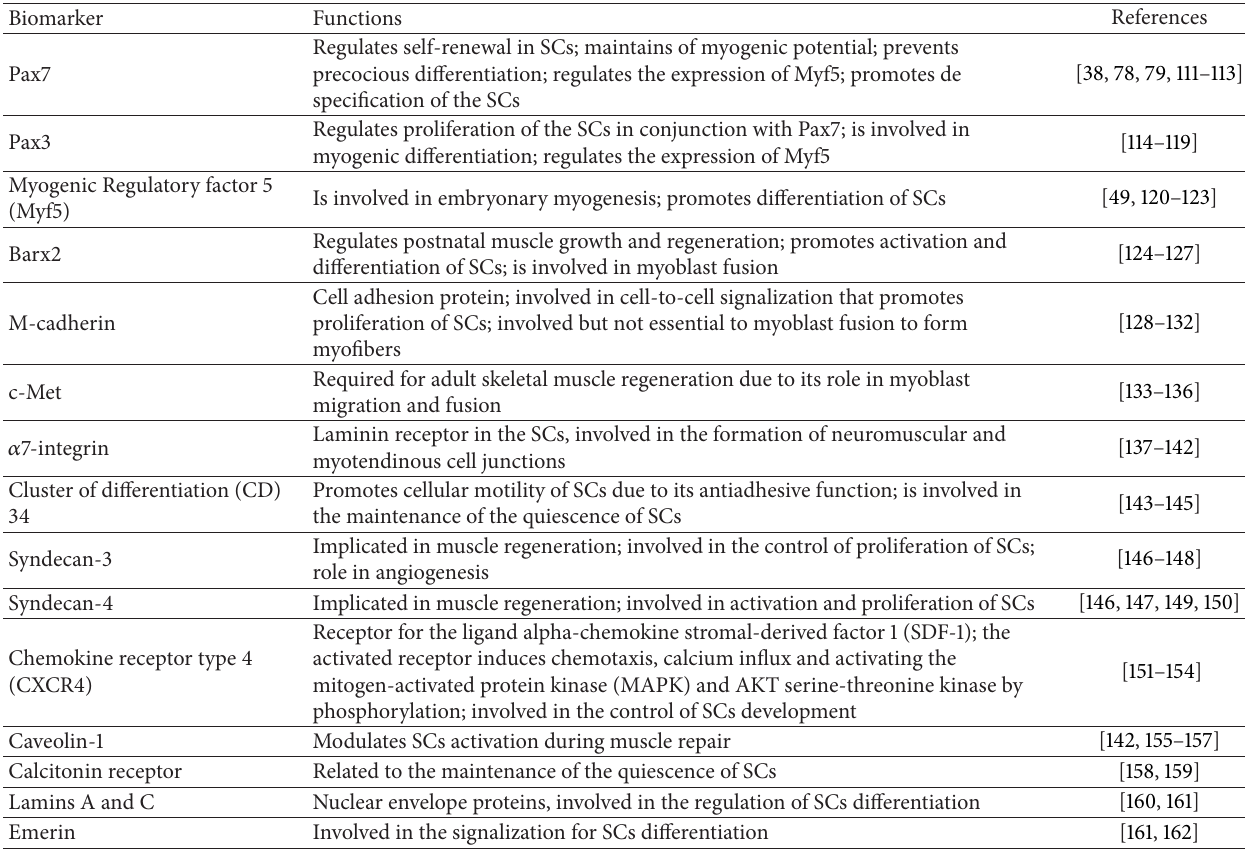
Table 1: Biomarkers expressed in most